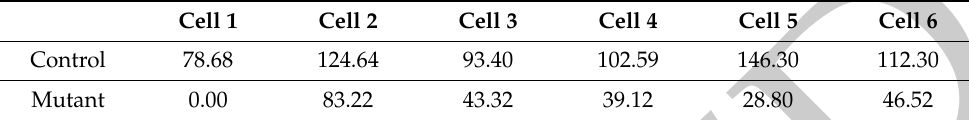
Table 1. Angle ◦ data for branching morphogenesis of controls and mutants.